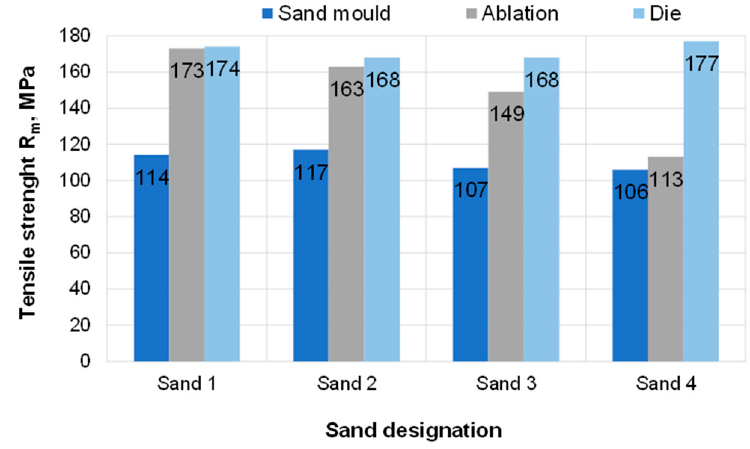
Figure 11. Tensile strength R m of the tested samples.